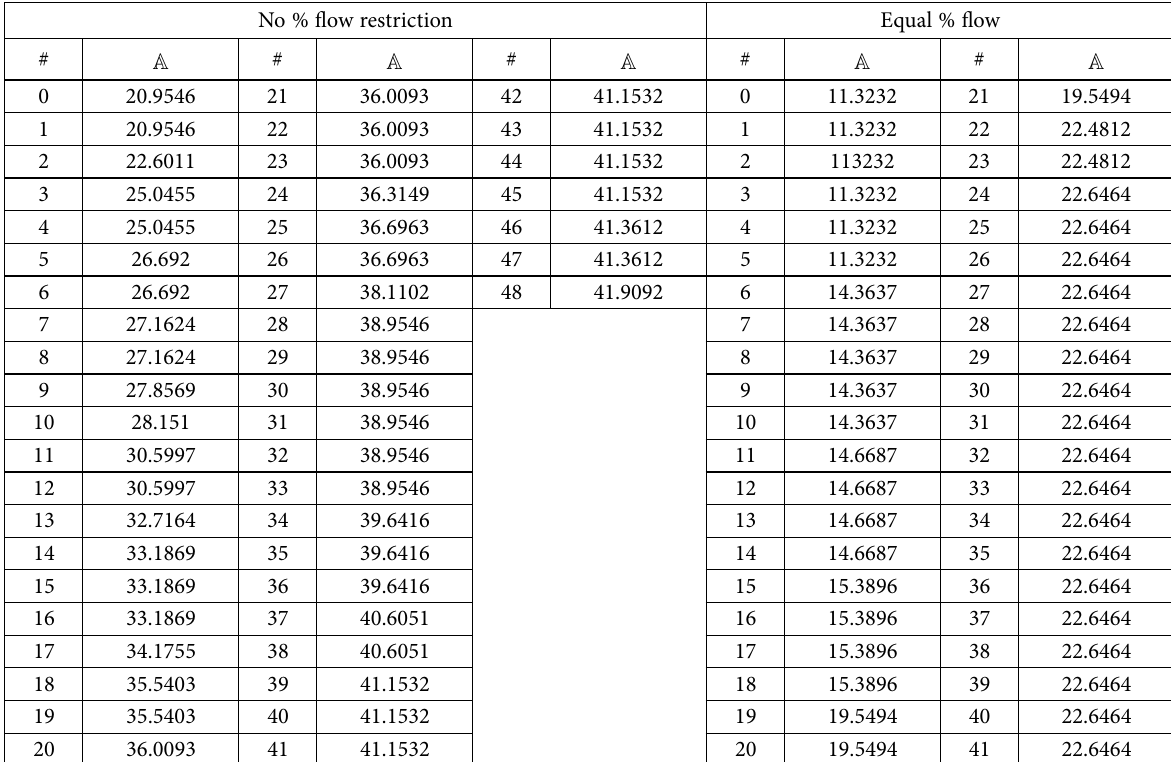
Table 12. Absolute capacity for incremental budget changes (